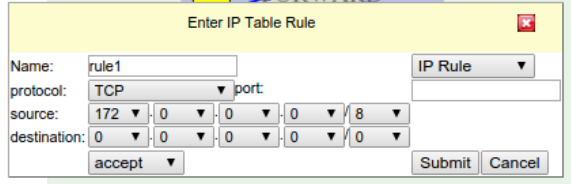
Fig. 8. An Example firewall router, graphically represented (the square represents an IP Table, the circles are IP Chains, and the linked rectangles are IP Rules)